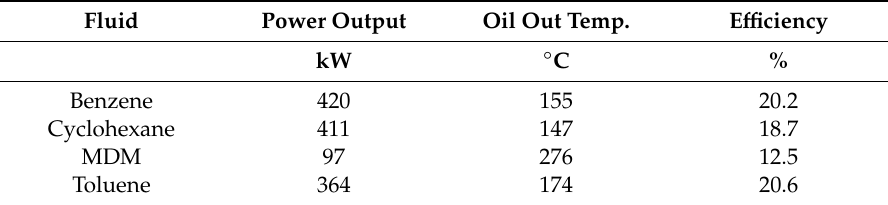
Table 1. Performance comparison of simple ORC cycles with di ff erent fluids.